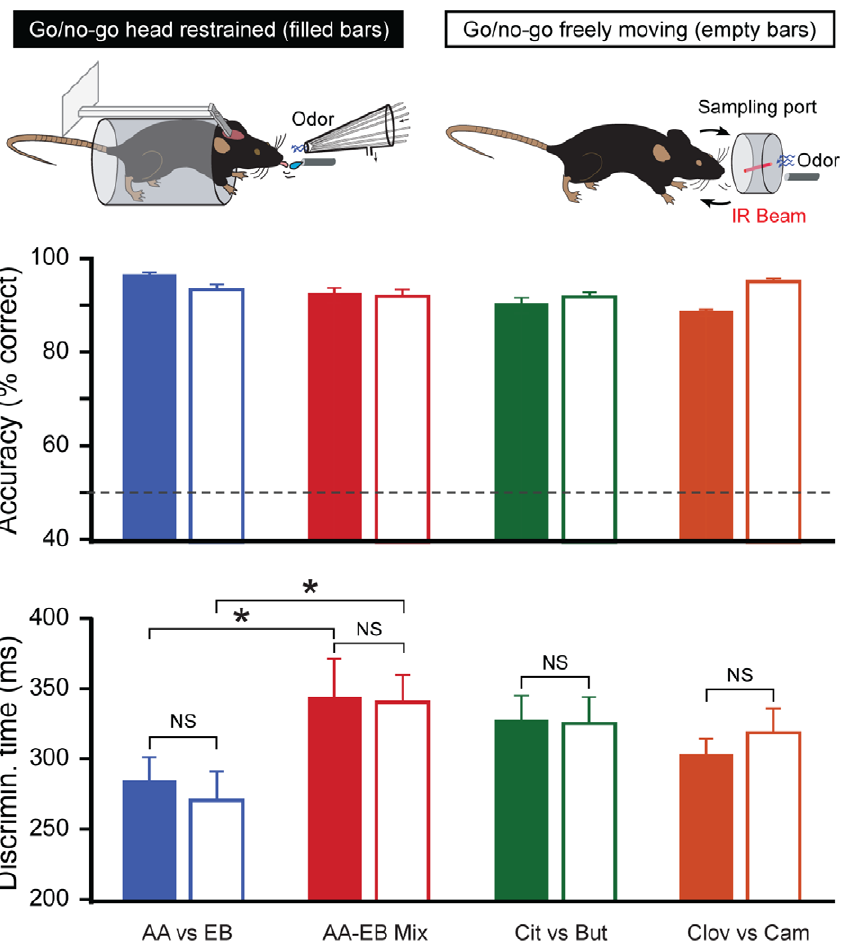
Figure 4. Similar discrimination abilities were observed under freely moving and head-restrained conditions. ( A ) Schema depicting head-restrained and freely moving paradigms. ( B ) Discrimination accuracy shown as the average percentage of correct choices, 300 trial blocks from which DT is calculated (filled bars represent head-restrained conditions on a go/no-go task and empty bars represent freely moving conditions on a go/no-go task) for AA vs EB (blue, n=8 mice, average 6 sem), binary mixtures of AA and EB (red, n=8 mice, average 6 sem), cit vs but (green, n=8 mice, average 6 sem) and clove vs cam (brown, n=8 mice, average 6 sem). Dotted line indicates chance level. ( C ) Stimulus dependent DTs were observed for go/no-go conditioning task under freely moving conditions and were similar to the DTs measured under head-restrained conditions (color codes and number of mice: same as above, all values are expressed as average 6 sem).